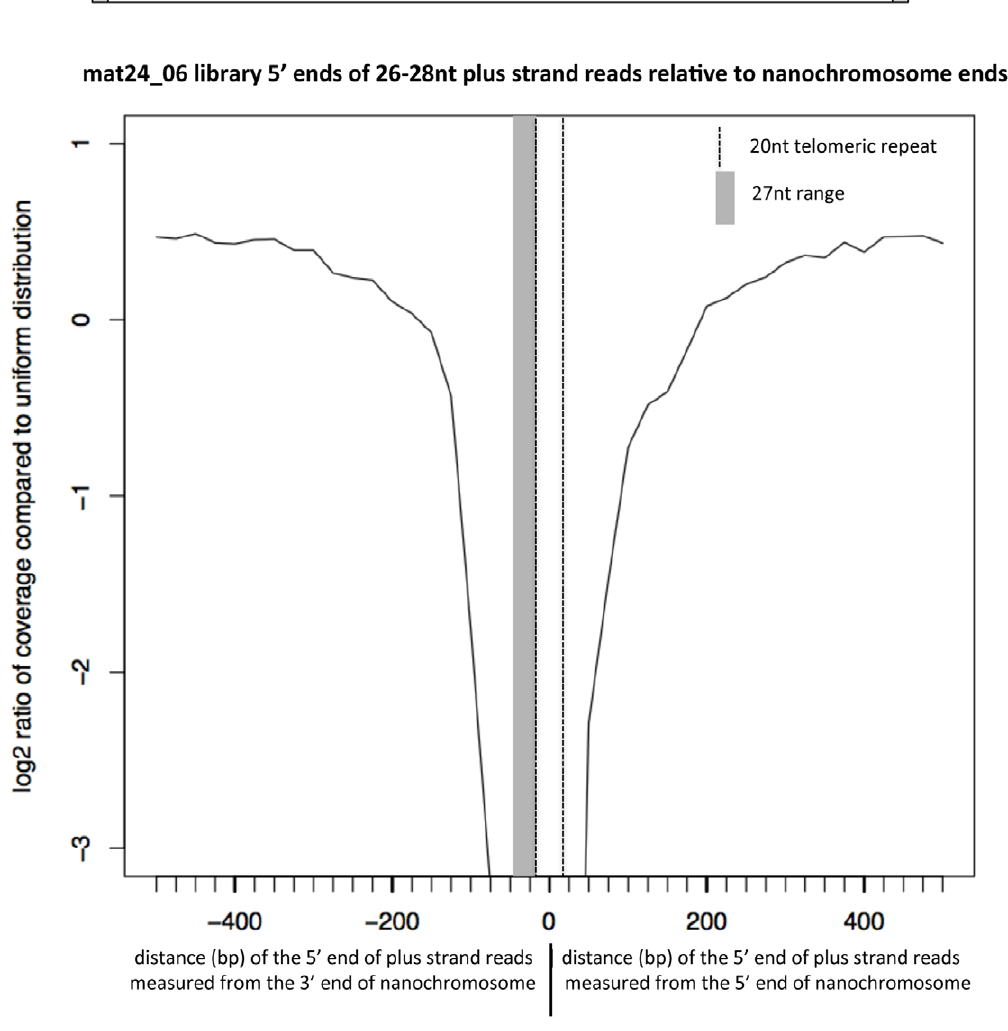
Figure 11. The first 30 nt of the nanochromosomes proximal to the telomeres have . 8-fold lower coverage of 26–28 nt small RNAs relative to the rest of the nanochromosome. Graphic at the top shows a nanochromosome (rectangle) with 20 nt telomere sequence in gray shadow. 27 nt small RNAs for the plus strand of the nanochromosome are indicated as arrows above the nanochromosome. The average density of the location of 5 9 ends of plus strand-aligning 26–28 nt RNAs was determined over 500 positions (in 20 bins of 25 bp each, shown by tick marks) relative to the 5 9 (right side, positive values) and 3 9 (left side, negative values) ends of 10,002 complete nanochromosomes. These densities were plotted relative to a uniform distribution of the aligned 26–28 nt RNAs over the same sets of 500 positions on the same nanochromosomes. A dotted line at 20 nt from either end is included on both sides of the zero point to indicate the average telomere length of 20 nt on the nanochromosome sequences to which these data were plotted. The shaded gray area, 27 nt wide, is included on the plot from the nanochromosome 3 9 end because the plus strand-aligning reads would have 27 nt of sequence between their plotted 5 9 end and the 3 9 end of the nanochromosome. When minus strand-aligning reads were analyzed by this same method, a mirror image plot was obtained that is otherwise identical to the graph for plus end reads (not shown).